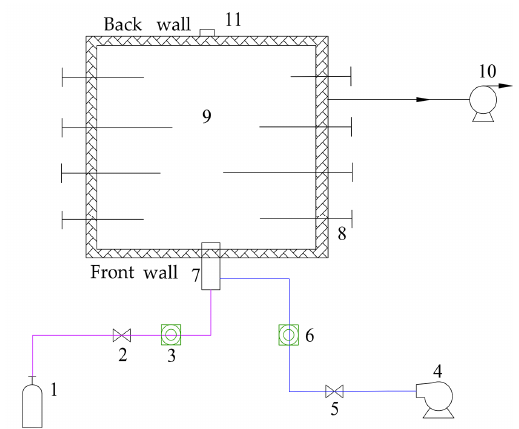
Figure 7. Layout of the combustion system. (1) Compressed gas cylinder, (2) gas valve, (3) gas flowmeter, (4) air fan, (5) air valve, (6) hotwire anemometer, (7) gas burner, (8) thermal couples, (9) combustion chamber, (10) induced draft fan, and (11) observation hole.